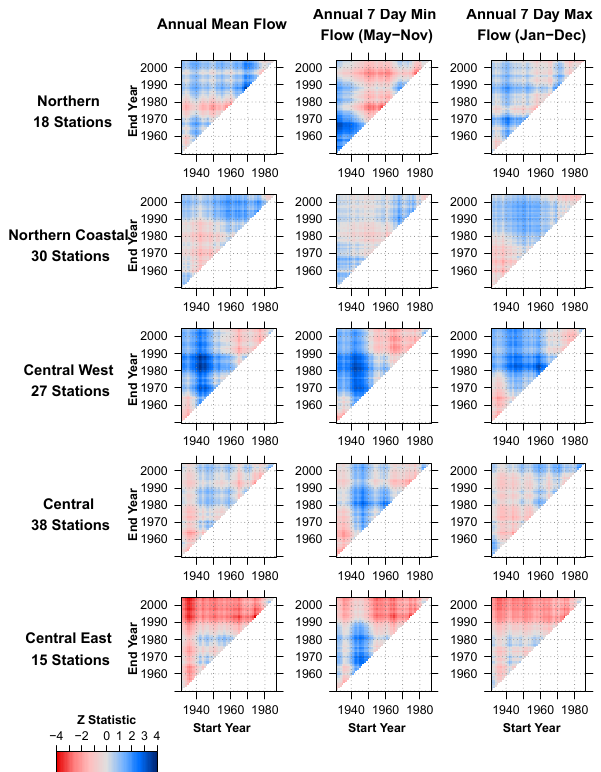
Fig. 5. Multi-temporal trend analysis for annual mean, AMIN7 and AMAX7. x-axis shows start year of trend, y-axis shows end. The MK test applied to all start and end years, and the corresponding pixel is coloured according to the resulting Z statistic (see legend), with red representing negative trends, and blue representing positive